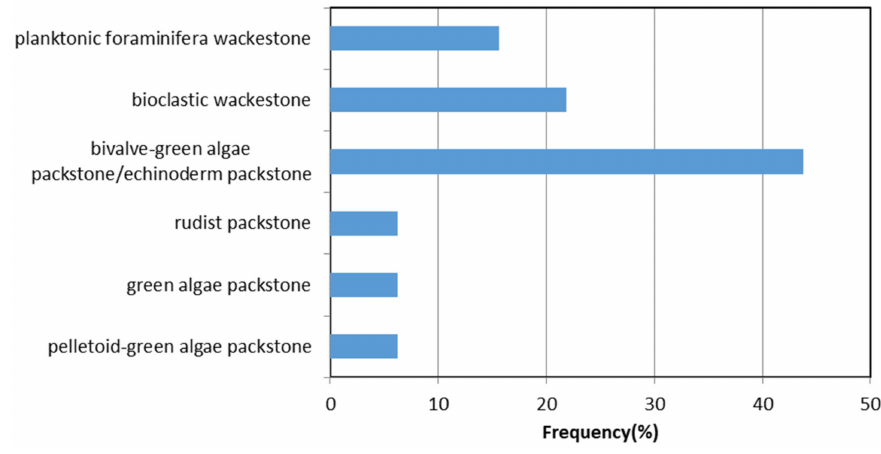
Figure 11. The frequency of stylolite in the different